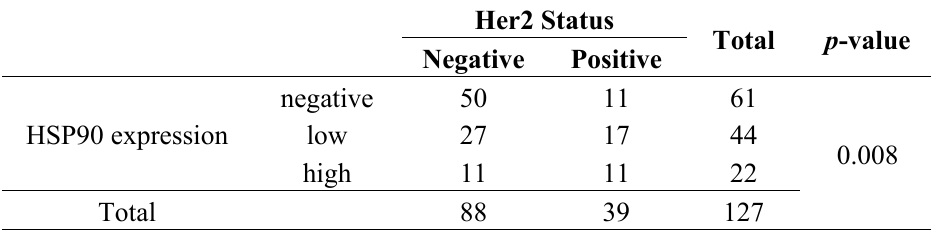
Table 2. Correlation between HSP90 expression and Her2 status.